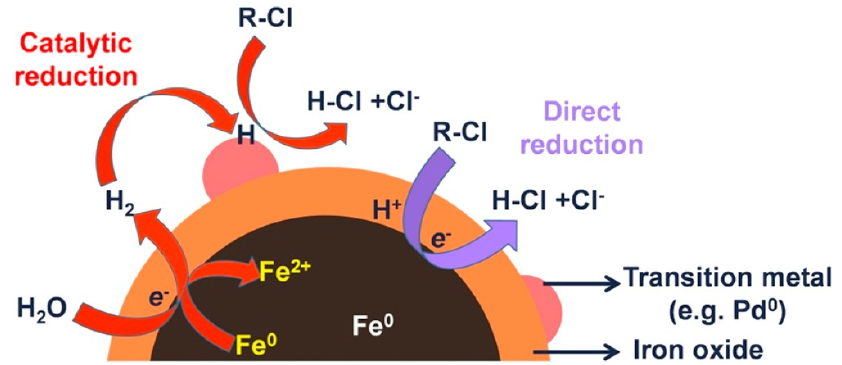
Figure 3. General dechlorination mechanism for BNP and NZVI. Reproduced with permission from Zhao et al. [29]. Copyright 2016 Elsevier.